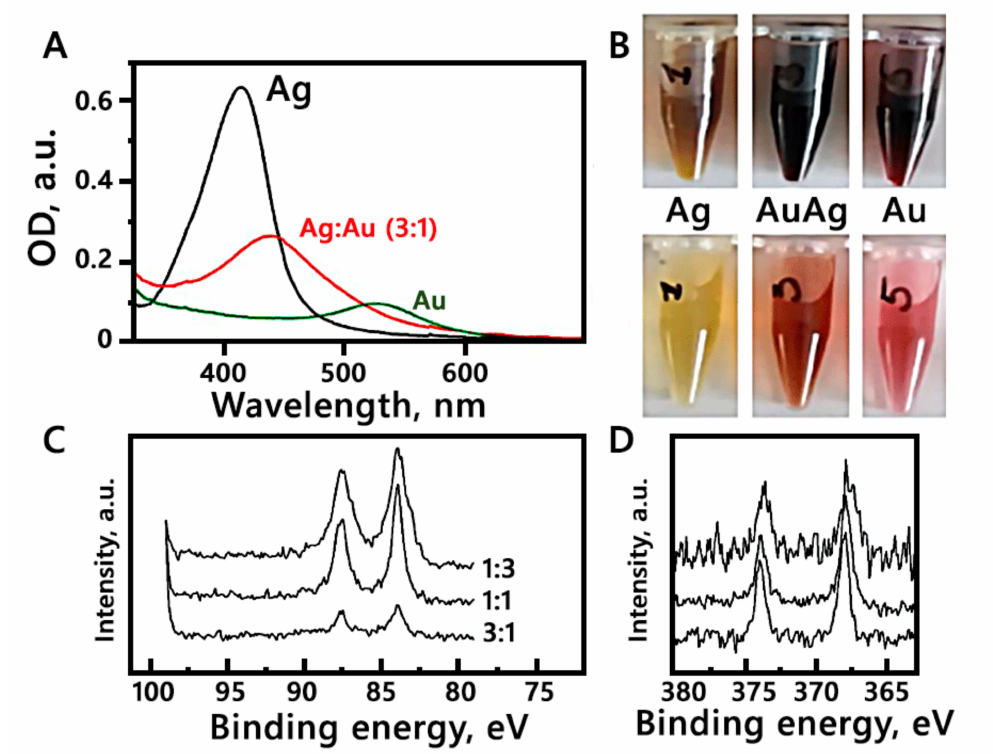
Figure 1. Panel ( A ) shows absorption spectrum of Ag, Au and AgAu NPs. Panel ( B ) shows Ag, Au and AgAu samples before (upper part) and after (lower part) dilution. Panels ( C , D ) show high- resolution XPS spectra of the series of bimetallic AgAu colloids, (AgAu(3:1), which was used in this study, AgAu(1:1) and AgAu(1:3)) in the range of Au and Ag ( D